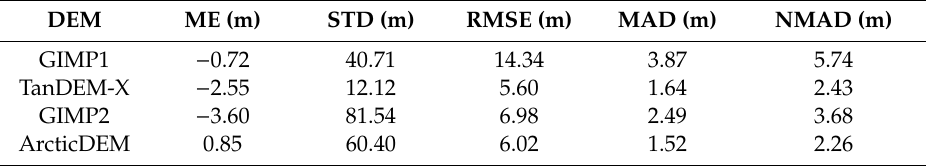
Table 6. Analysis of sampling points among Greenland Ice Map Project (GIMP)1, TanDEM-X, GIMP2, and